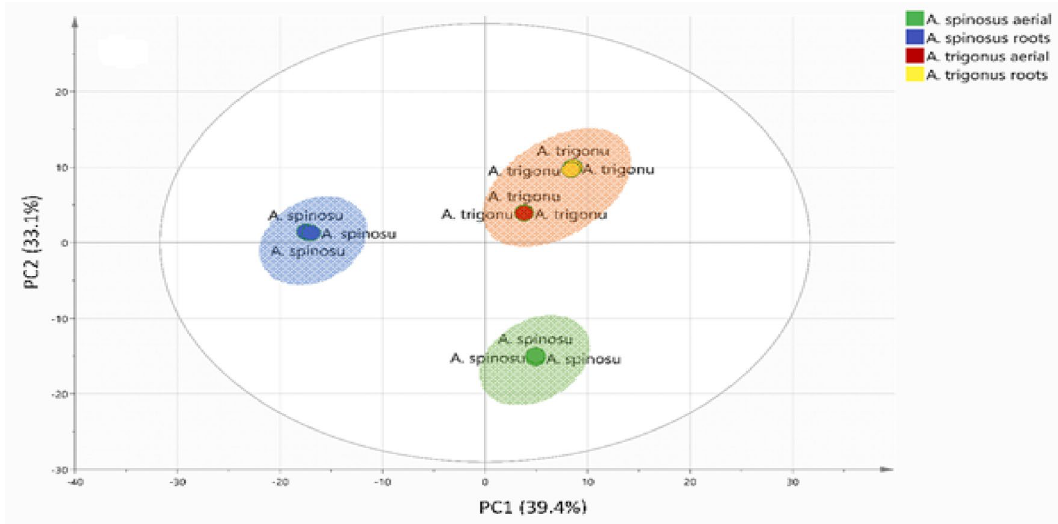
Figure 2. Score scatter plot of principal component analysis using UPLC-ESI- TQD-MS, n = 3. represented by first two